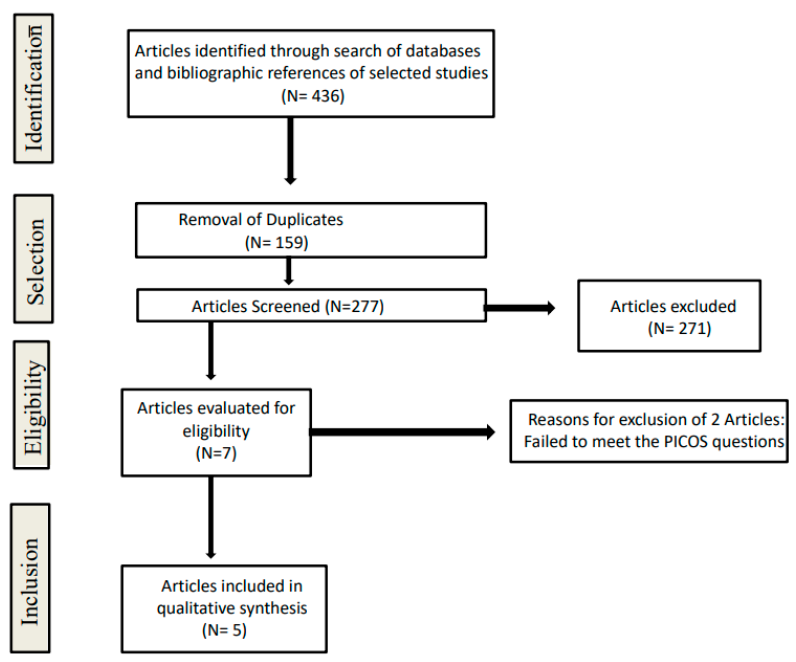
Figure 1. PRISMA fl ow chart of selection process. Figure 1. PRISMA flow chart of selection